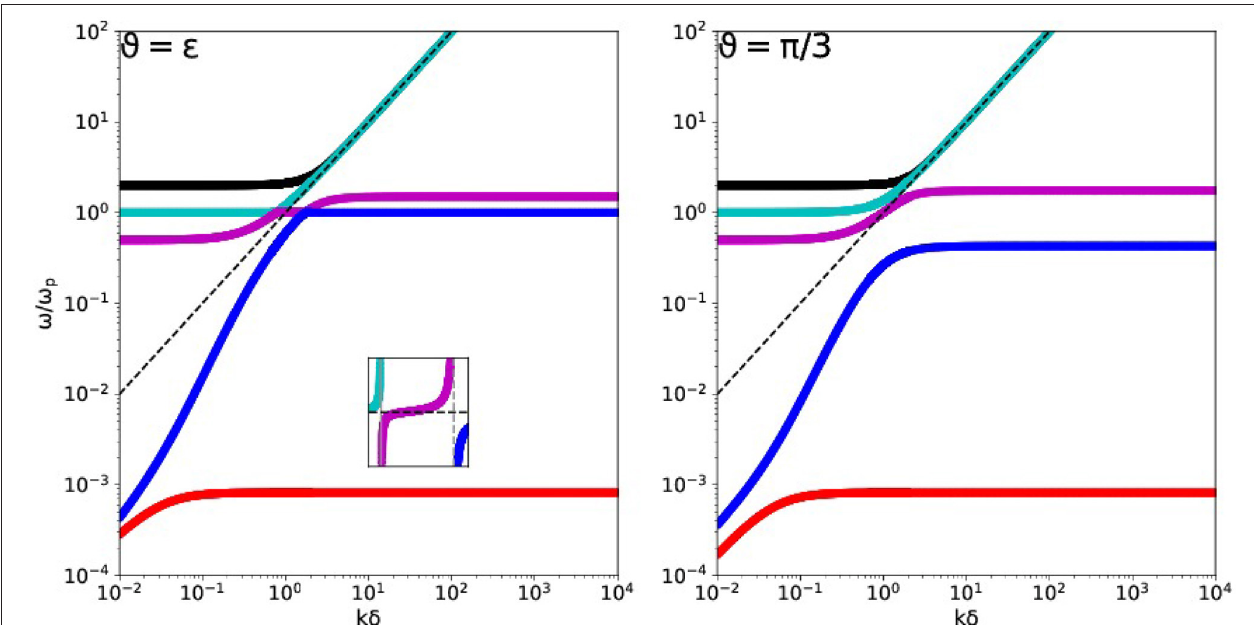
π/ 3 0.001 (left) and oblique ϑ = =